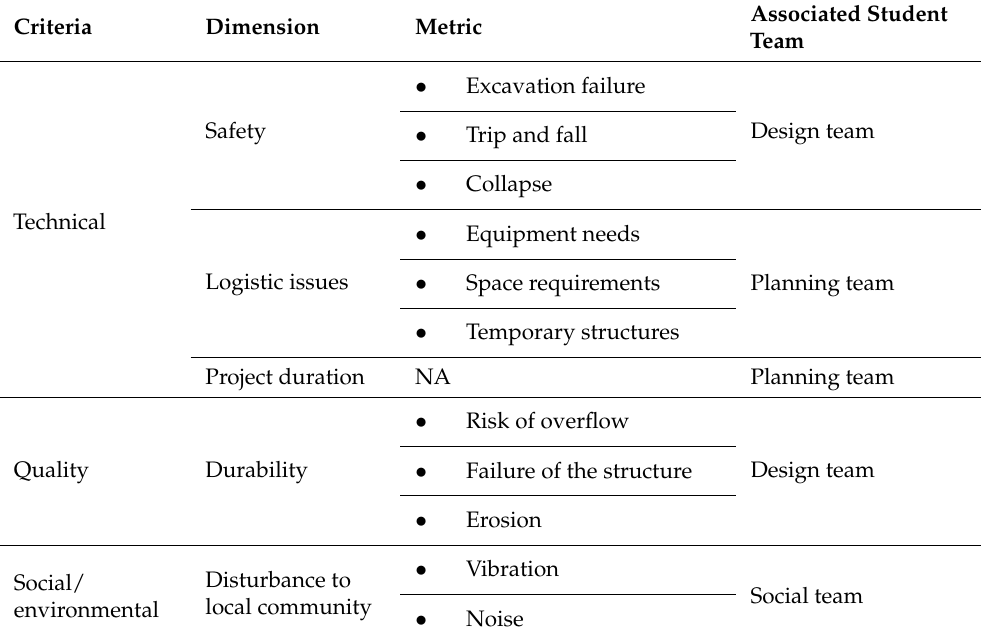
Table 3. Criteria selected by the